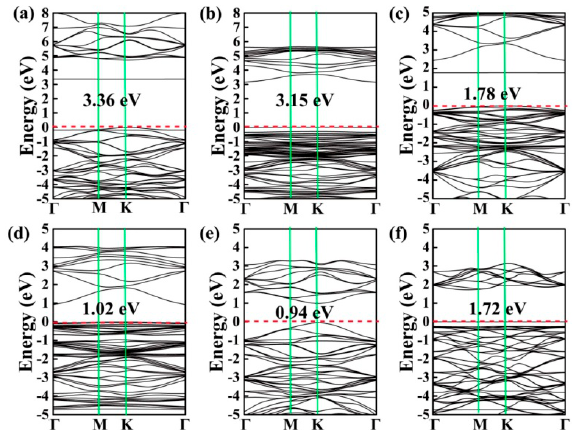
Figure 5. Band structures of CH 2 O on the surface of the ( a ) BN, ( b ) AlN, ( c ) GaN, ( d ) InN, ( e ) BP, and ( f ) P monolayers.